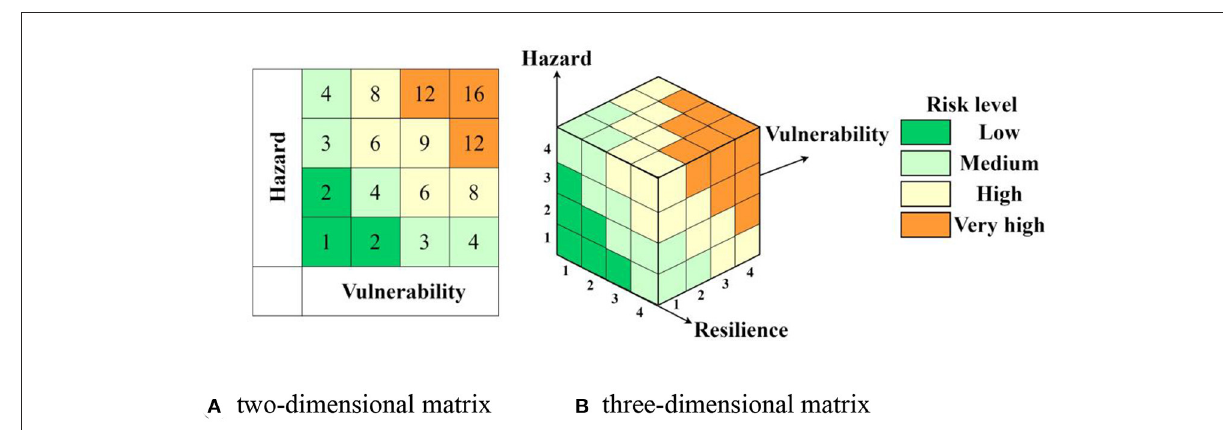
FIGURE2 Assessment matrixes of pollen-allergy risk. (A) Two-dimensional matrix. (B) Three-dimensional